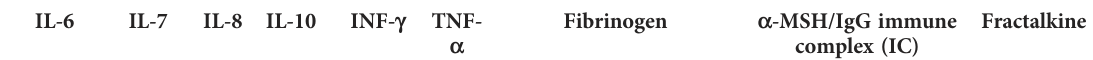
TABLE 2 Results based on individual immune/in fl ammation markers.